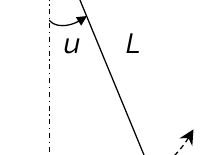
Figure 5. A simple pendulum.